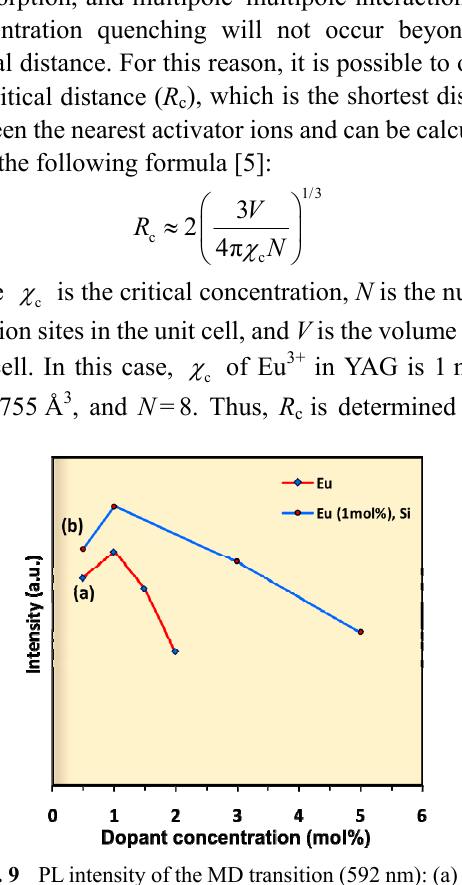
Fig. 10 Logarithmic plot of I / x as a function of the activator concentration x for